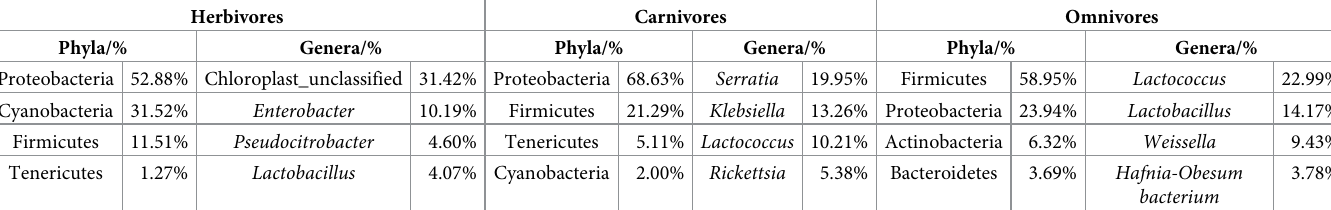
Table 3. Top 4 abundance gut bacteria at the phyla and genera levels of samples with different feeding